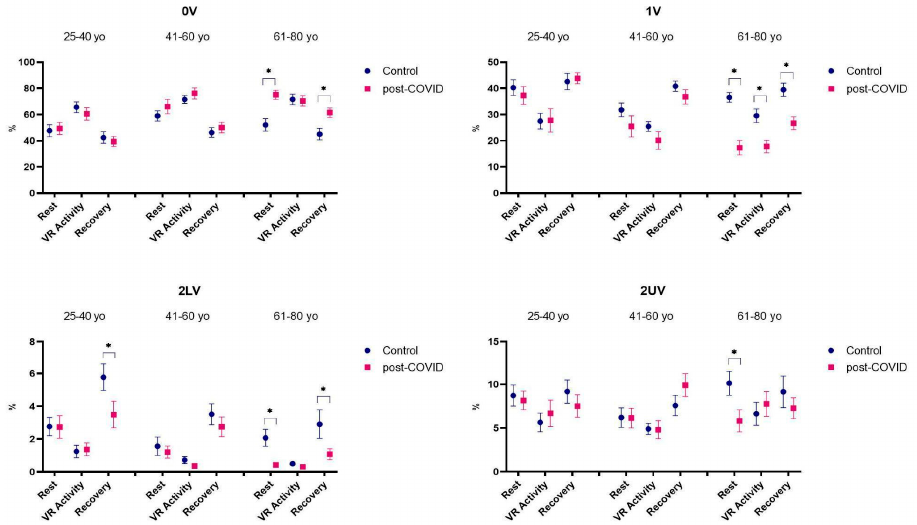
Figure 5. Representation of the mean and standard error of symbolic dynamic indices of HRV between groups (Control and post-COVID), ages (25–49 yo, 41–60 yo, and 61–80 yo), and moments (Rest, VR activity, and Recovery). Yo: years-old; VR: Virtual Reality; %0 V: no variation—reflects sympathetic modulation, %1 V: one variation—reflects global variability, %2 LV: two like variations, and %2 UL: two unlike variations—reflect parasympathetic modulation; * p < 0.05 between groups. In turn, for the %1 V and %2 LV indices, the post-COVID group presented lower values (M = 28.1 and M = 1.5) compared to the control group (M = 34.9, p < 0.001 and M =